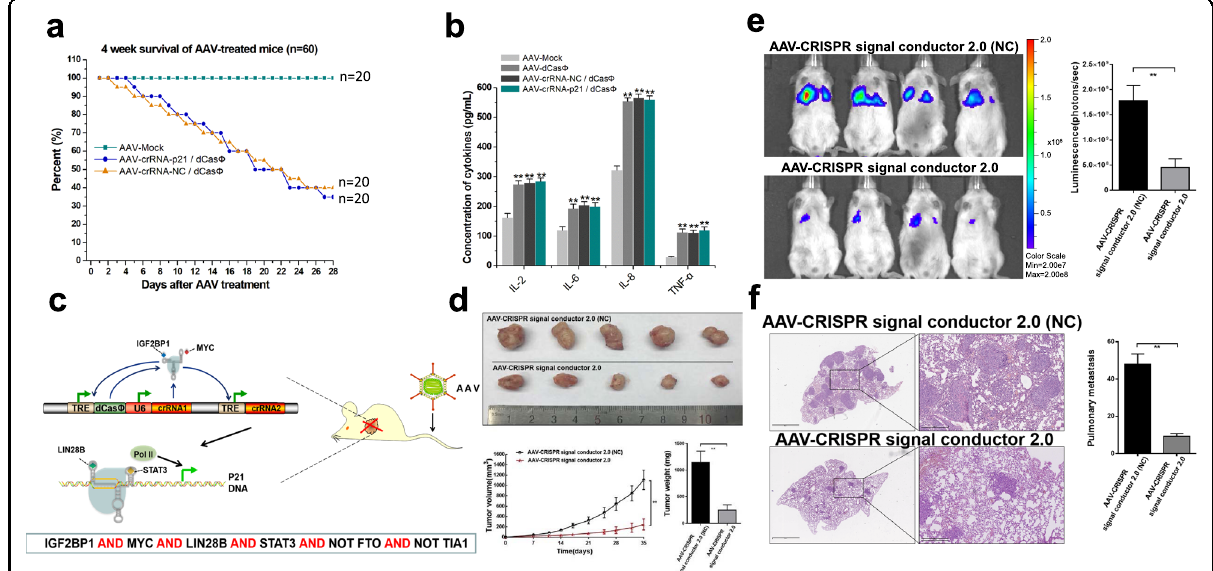
Fig. 8 Inhibition of tumor growth and metastasis in vivo by AAV-dCas Φ . a The survival curve of mice showed that the tail vein injection of AAV- dCas Φ signi fi cantly shortened the survival time of the mice. b The ELISA method was used to detect the expression changes in immune-in fl ammatory indicators in the peripheral blood of mice after tail vein injection of AAV-dCas Φ . c Schematic diagram showing the six-input logic gate controlled by CRISPReader. d AAV-CRISPR signal conductor 2.0 ef fi ciently inhibited in vivo tumor growth. The tumor volume and weight were measured at the indicated time points after cell transplantation into mice. The in vivo growth of tumors treated with the AAV-CRISPR signal conductor 2.0 was dramatically slower than that of tumors treated with the negative control using non-targeting crRNA. e Quanti fi cation of bioluminescence images of a metastatic model. The luminescence signal intensities are shown. f Histopathological inspection of mouse lungs treated with AAVs. Lungs were examined with H&E staining, and lung sections from the mice injected with different AAVs were analyzed 4 weeks after treatment. Pulmonary metastases of various sizes were observed. The data are shown as the means±SD. * P <0.05; ** P <0.01, between the groups, two-tailed t